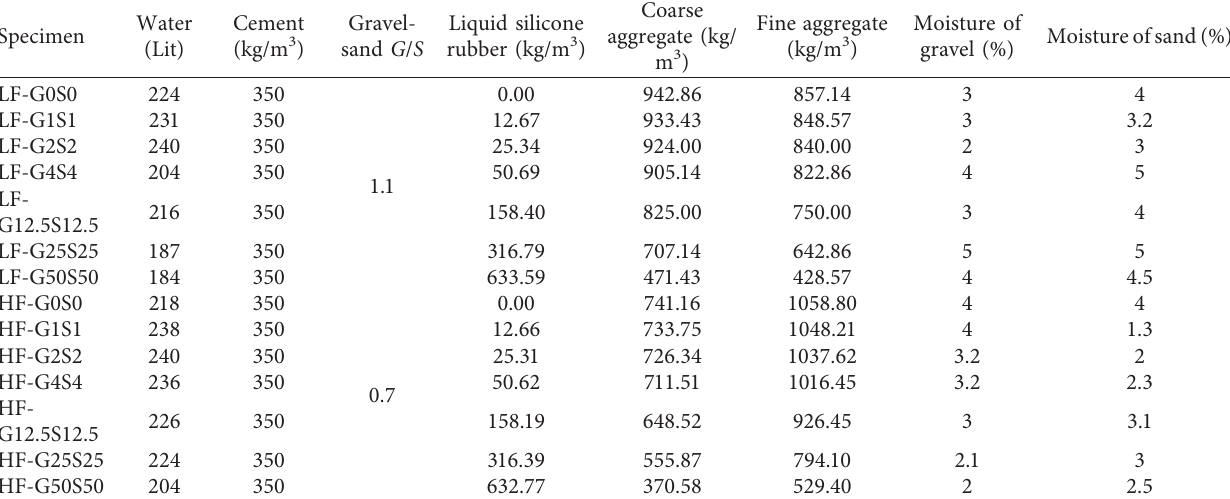
Table 4: Concrete mixture